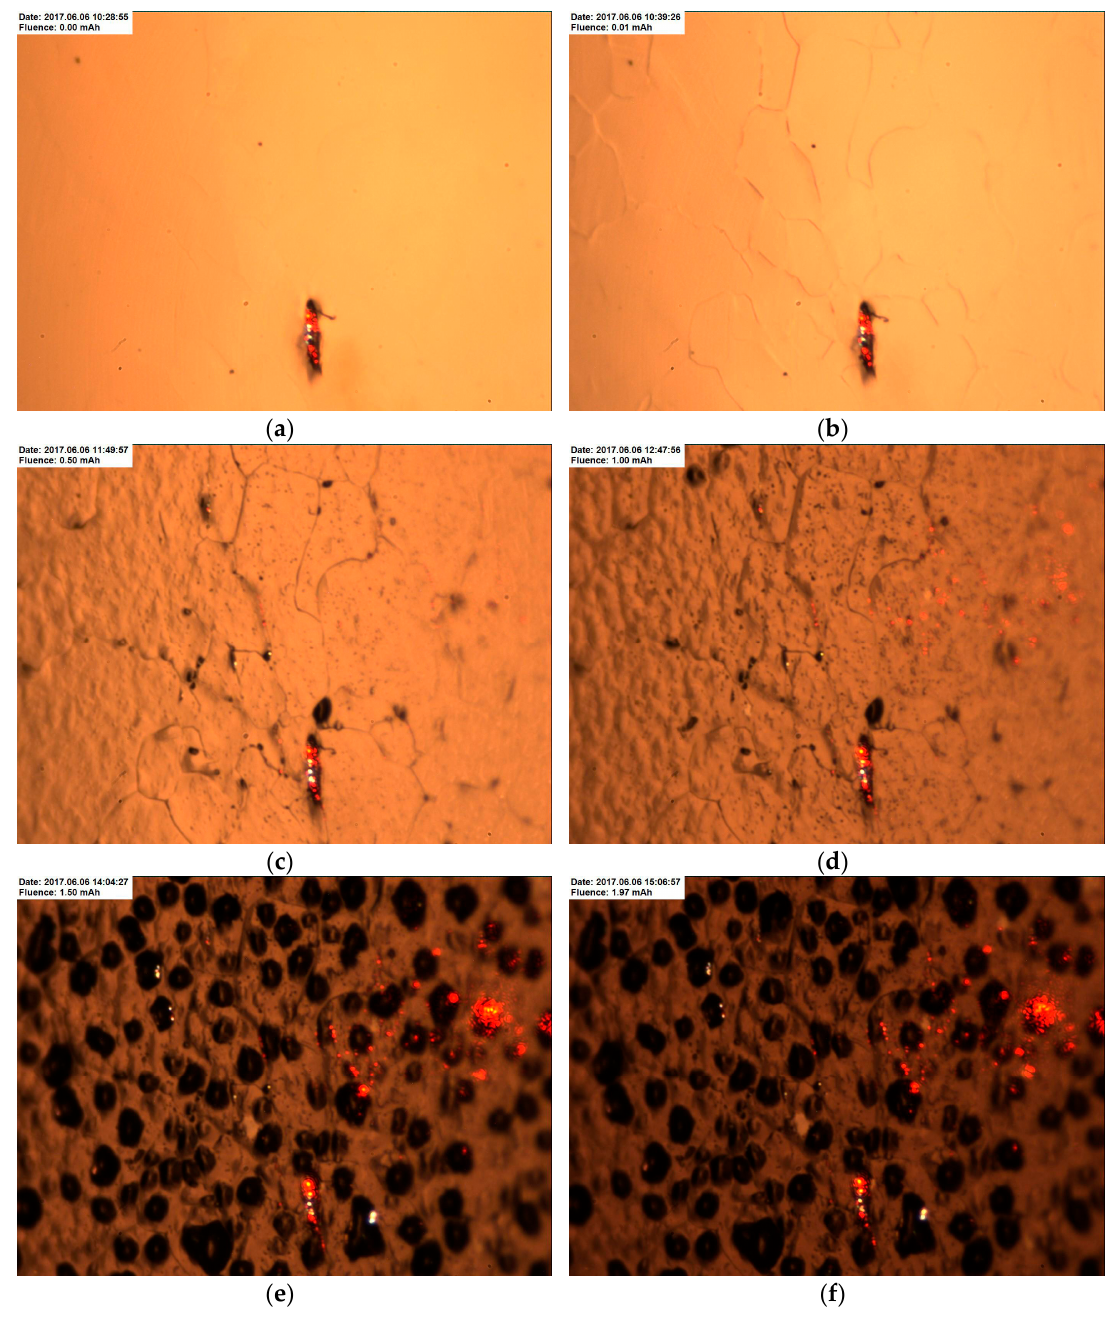
Figure 18. Images of the surface of 99.99996% fine-grained copper (Sample 4) during irradiation by a 2-MeV proton beam with varying integrals of the current: ( a ) 0.00, ( b ) 0.01, ( c ) 0.50, ( d ) 1.00, ( e ) 1.50, ( f ) 1.97 mA·h. The frame size is 9 mm horizontally and 4 mm vertically.